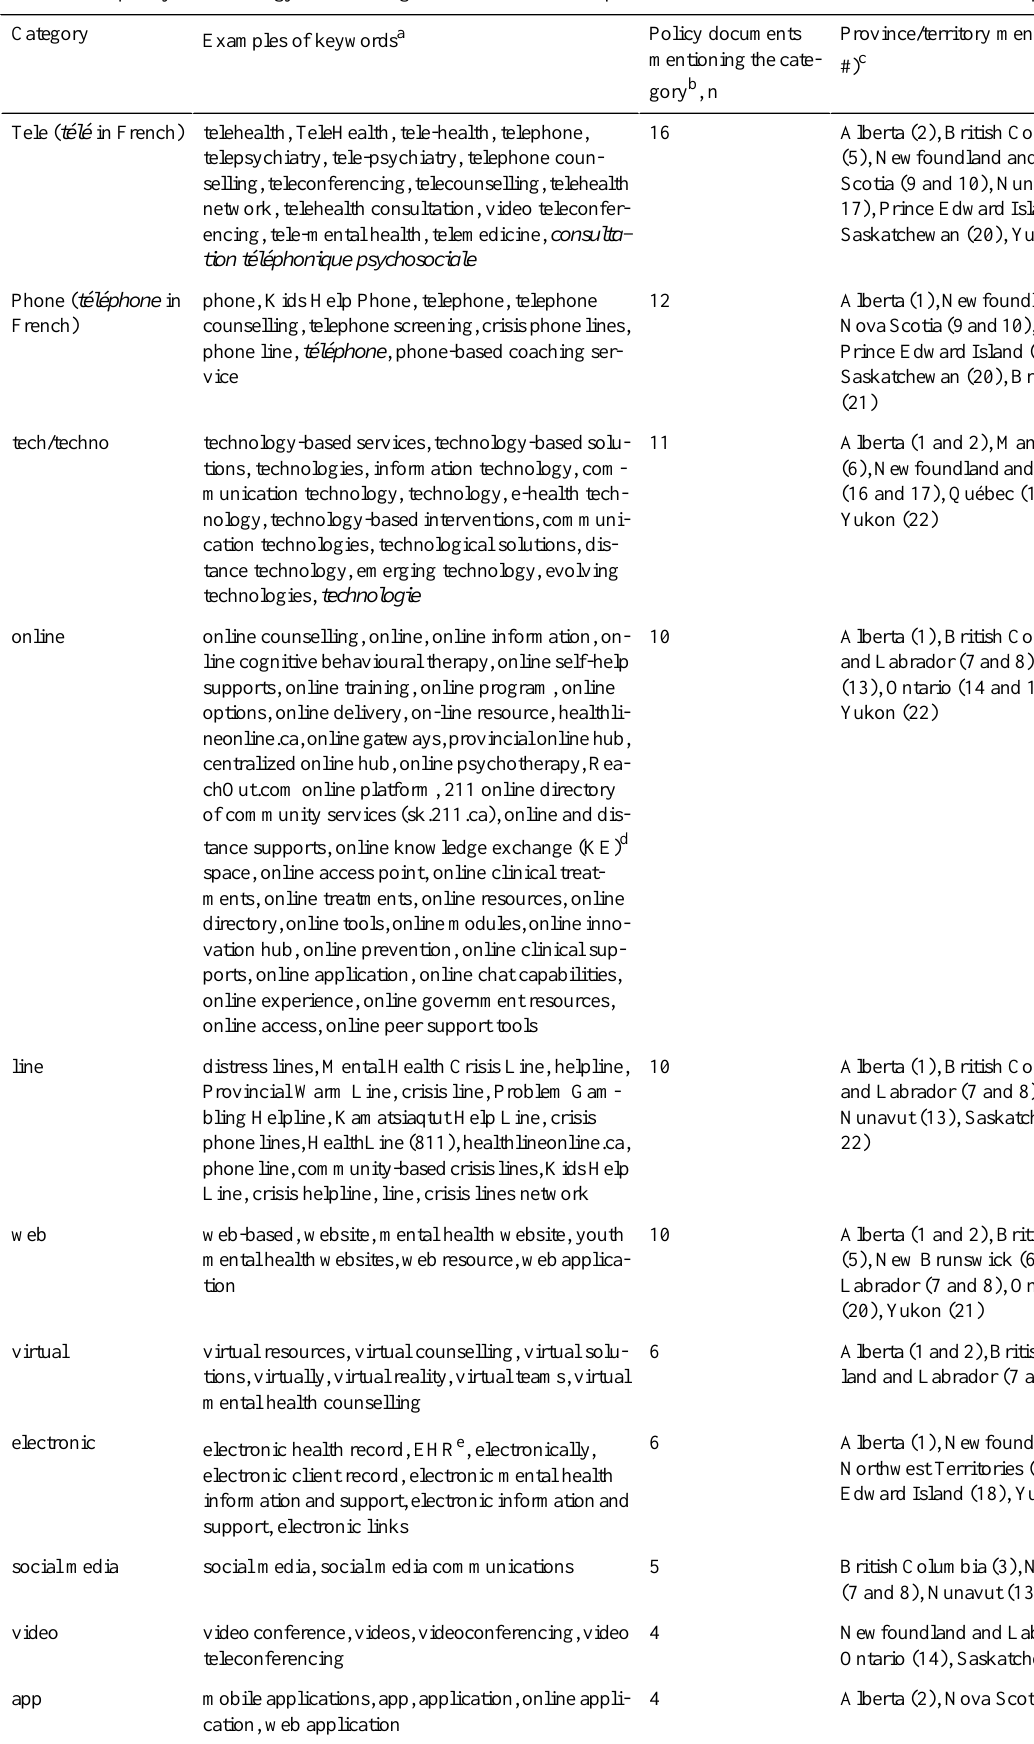
Table 2. Frequency of technology-related categories mentioned in the provincial/territorial mental health and addictions policy documents.